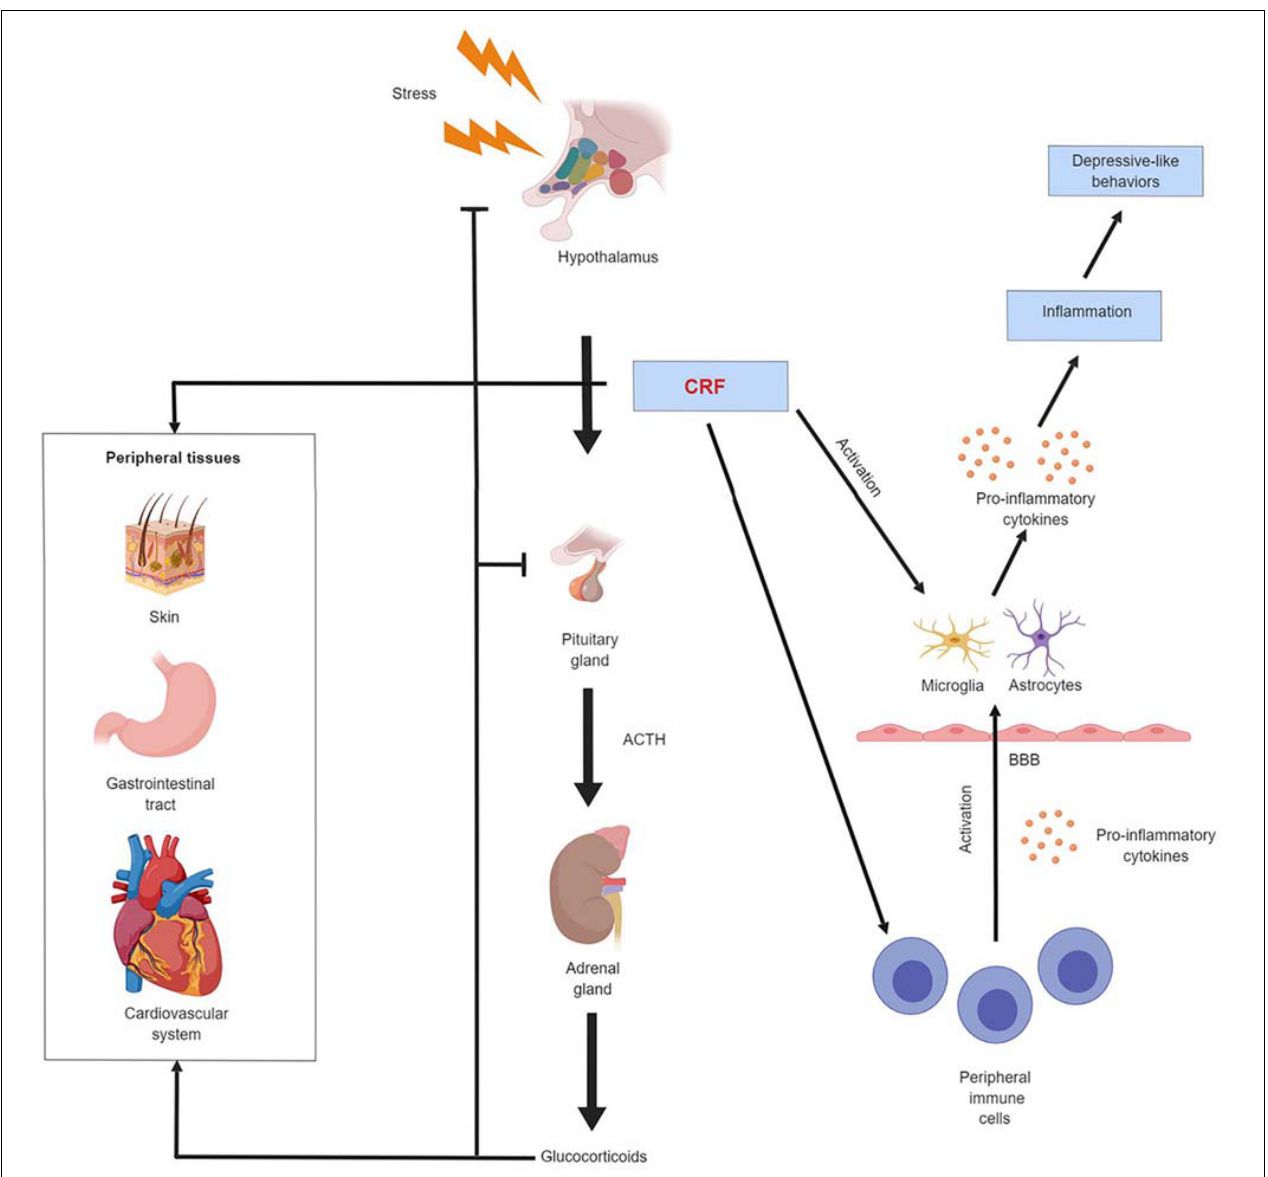
FIGURE 1 | Schematic illustration of CRF regulation of the endocrine and immune system in depression. CRF mediates the activity of the HPA axis and the neuroimmune system. It also exerts regulatory effect on other peripheral tissues such as skin, gastrointestinal tract and cardiovascular system. Chronic exposure to stress results in CRF hypersecretion and HPA axis hyperactivity. Elevated CRF level stimulates the production of pro-inflammatory cytokines by peripheral immune cells, these peripheral cytokines can cross the blood-brain barrier and activate astrocytes and microglia in the CNS. CRF can also directly activate astrocytes and microglia. The activated astrocytes and microglia secrete more pro-inflammatory cytokines. These astrocytes- and microglia-derived cytokines have a broad effect on the CNS, drive neuroinflammation and produce depression-like behavioral alterations.